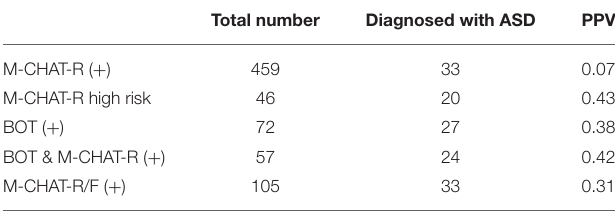
TABLE 1 | PPVs of M-CHAT-R, M-CHAT-R/F, and